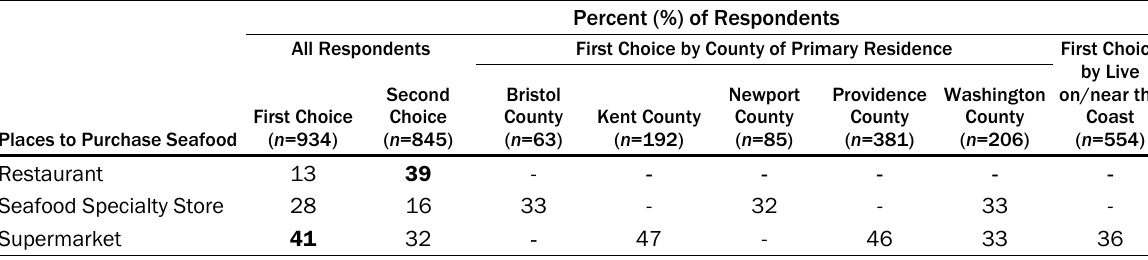
Table 3. Top Three Places to Purchase Seafood, Ranked First and Second